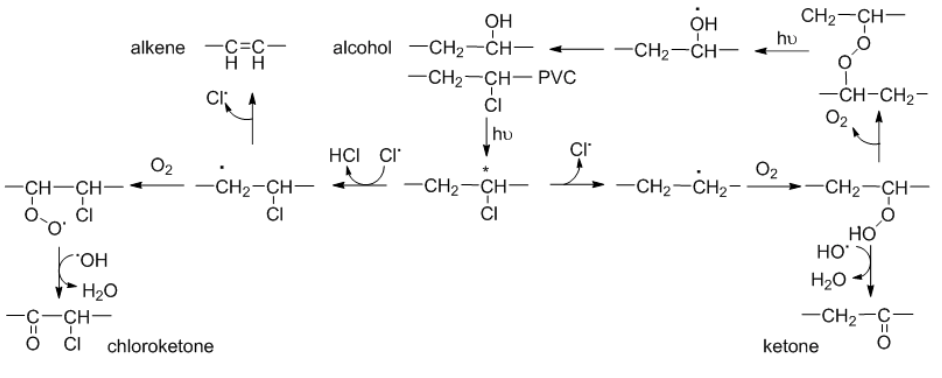
Figure 4. Formation of polyene, carbonyl, and hydroxyl containing fragments from PVC photo-oxidation.